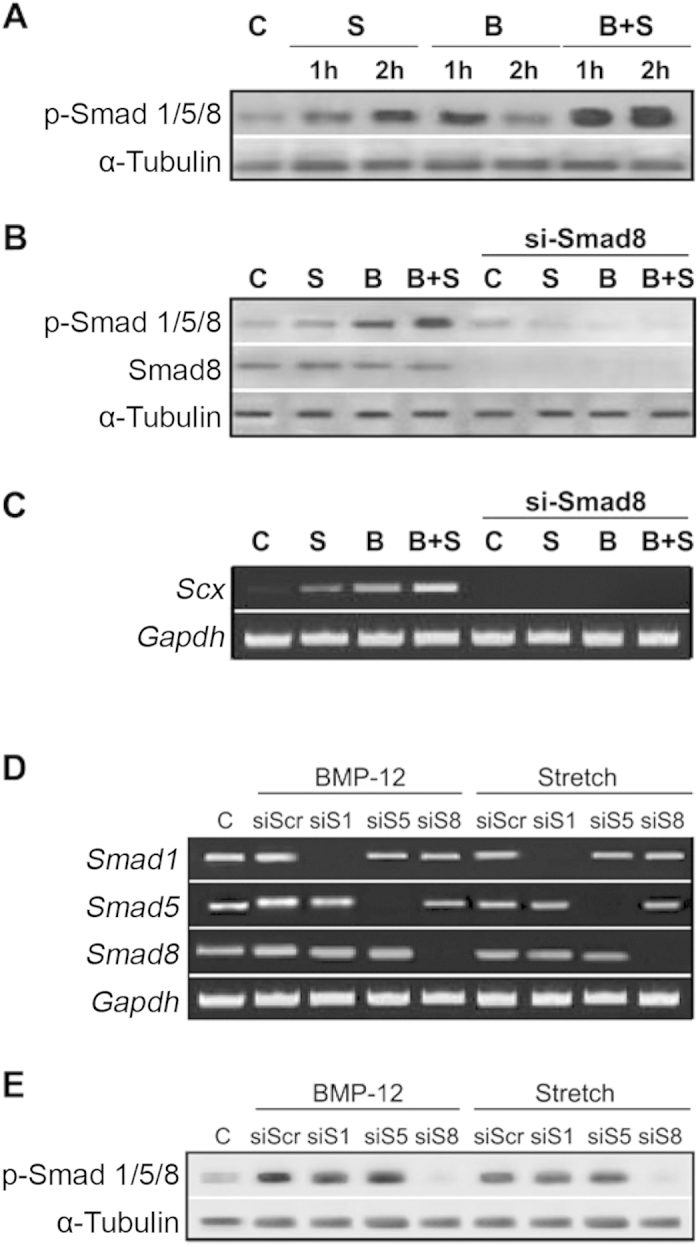
Dependency of Smad8 activation in BMP-12 and cyclic stretch loading signals.(A) Enhanced Smad 1/5/8 phosphorylation induced by combined treatment of BMP-12 and cyclic stretch loading. Cells under indicated treatment were harvested at 1 hour and 2 hours post-treatment to analyze the levels of Smad1/5/8 phosphorylation by Western blot. (B–E) Activation of Smad8 in C3H10T1/2 stem cells in response to BMP-12 and stretch loading. Cells were transfected with siRNA against Smad1, Smad5, Smad8, or control siRNA, (siScr) followed by treatment of BMP-12 or loading or both, and protein phosphorylation analyzed by Western blot. C: Control, B: BMP-12 only, S: stretch loading only, B + S: BMP-12+stretch loading, Scr: Scramble of siRNA, siS1: siRNA-Smad1, siS5: siRNA-Smad5, siS8: siRNA-Smad8.